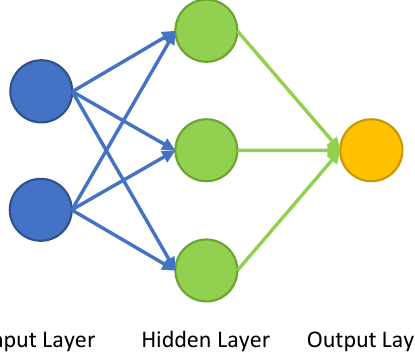
Figure 4. Schematic representation of a machine learning algorithm (MLA) showing a different layer, after